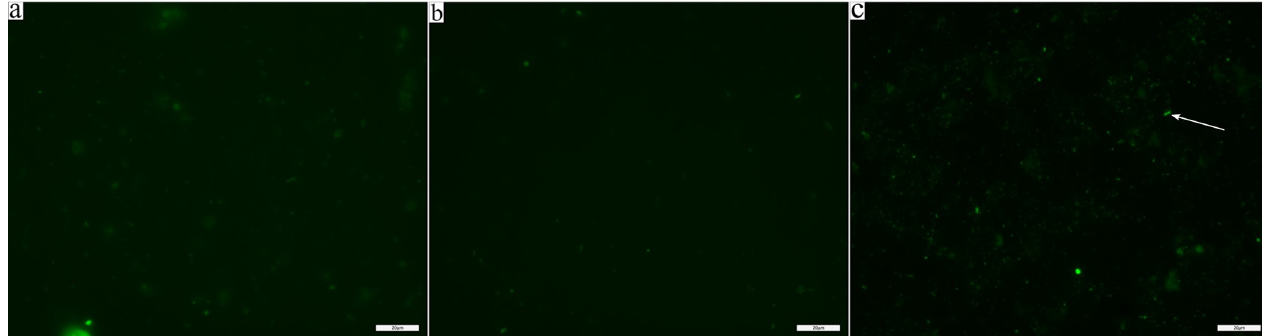
Fig 1. Phage probes are specific to the targeted phages. Phage signals are highly specific to the targeted groups. All images are recorded in the FITC filter for phage signals. a) Smear of faecal sample F12 stained with DAPI dye only. Auto-fluorescent debris is vaguely visible. No DNA probes are hybridised to this sample. b) Smear of faecal sample F12 stained with DAPI dye, EUB338-Cy3, nonEUB338-Cy5, and phage probe group E amplified with Alexa Fluor 488 tyramides. Faecal sample F12 does not contain the target sequence for phage probe group E (Table 1), therefore no phage signal is visible and only debris is visible. c) Faecal sample F49 stained with DAPI dye, EUB338-Cy3, nonEUB338-Cy5, and probe group E amplified with Alexa Fluor 488 tyramides. Faecal sample F49 does contain the target phage genome for phage probe group E. Phage signals are clearly visible as single dots of intense signal and intense signals in the shape of single cells (white